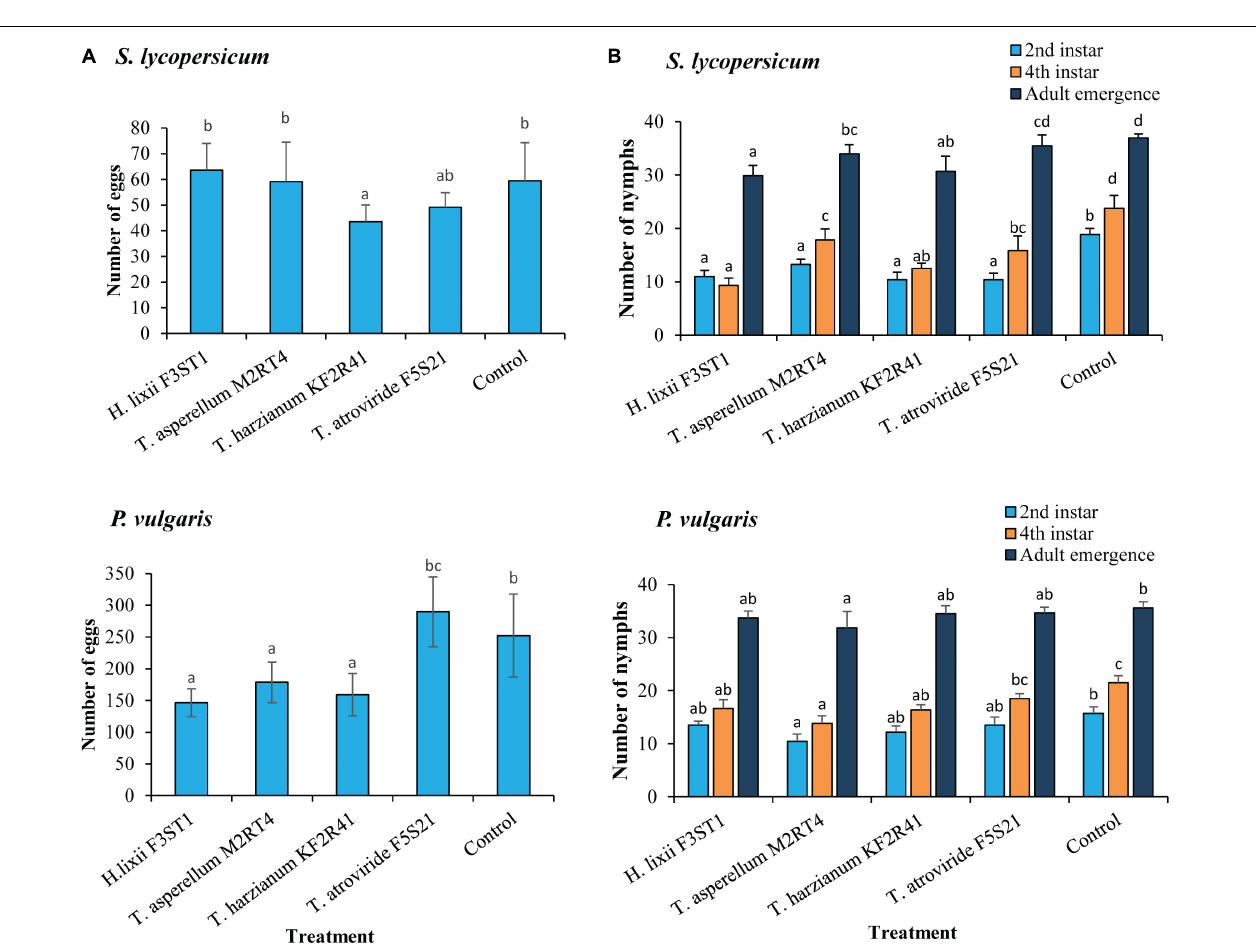
FIGURE 3 | Trialeurodes vaporariorum oviposition (A) and nymph development (B) negatively affected by endophytically colonised S. lycopersicum and P. vulgaris plants inoculated with H. lixii F3ST1, T. asperellum M2RT4, T. atroviride F5S21, and T. harzianum KF2R41. Error bars represent the SE ( ± SE) of the means at 95% CI (Tukey’s HSD test, P ≤ 0.05). Bars indicated by the same letters are not significantly different.